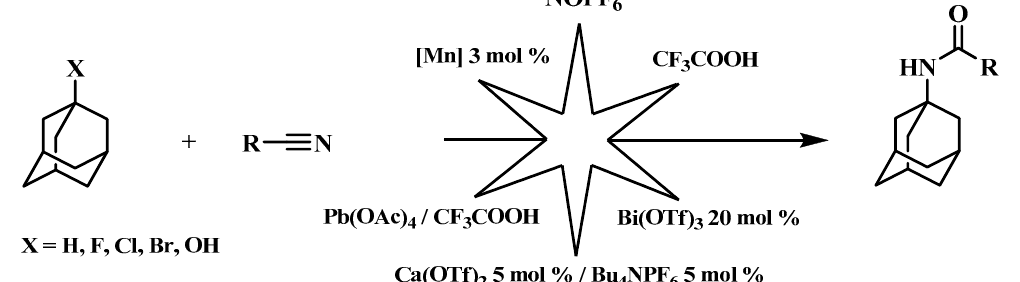
Figure 3. Synthesis of adamantylated amides by the Ritter